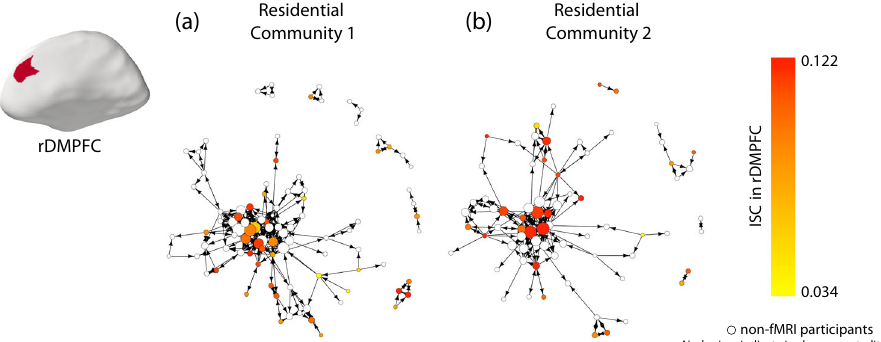
Fig. 3 Visualization of participant-level ISC results in the social networks. Visualizations of the social networks of ( a ) residential community 1 and ( b ) residential community 2 of a fi rst-year dorm. Each participant was a resident of one of two distinct residential communities, where one “ community ” consists of the set of people who live in the same wing and fl oor of a residence hall. Each node (which we show as a disc) represents one resident who was living in one of the communities, and each line segment represents one directed edge between two nodes if it is unidirectional and represents two directed edges if it is bidirectional. For example, an arrow from node A to node B conveys that node A nominated node B as a friend. An edge with two arrowheads indicates a mutually nominated friendship. The size of a node represents its in-degree centrality, with larger nodes indicating individuals with higher in- degree centralities. The color of the nodes represents a node ’ s mean neural similarity in the rDMPFC to other members of its residential community, with darker colors indicating greater neural similarities. As this fi gure indicates, individuals with higher in-degree centralities (i.e., individuals who many other individuals nominated as a friend) tended to have the largest mean ISCs with their peers in the rDMPFC. Source data are provided as a Source Data fi